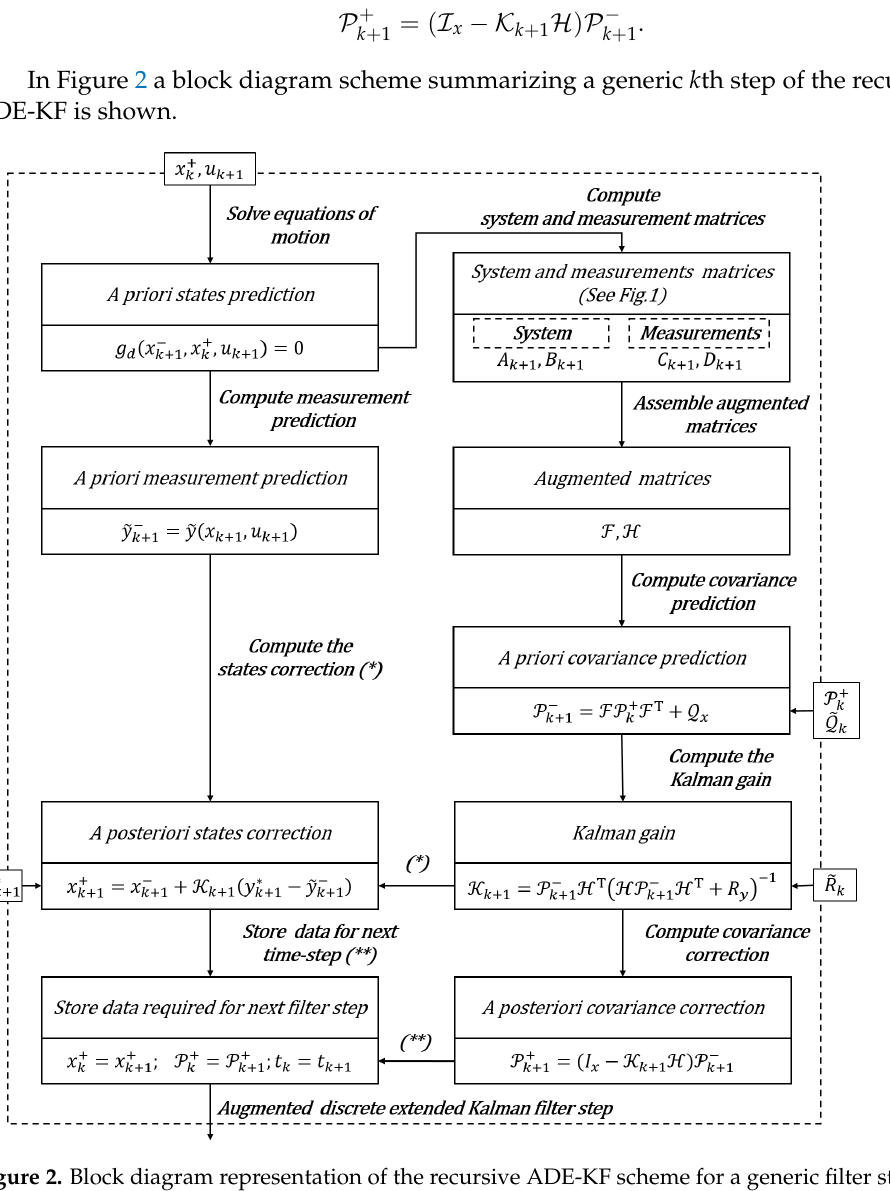
Figure 2. Block diagram representation of the recursive ADE-KF scheme for a generic filter